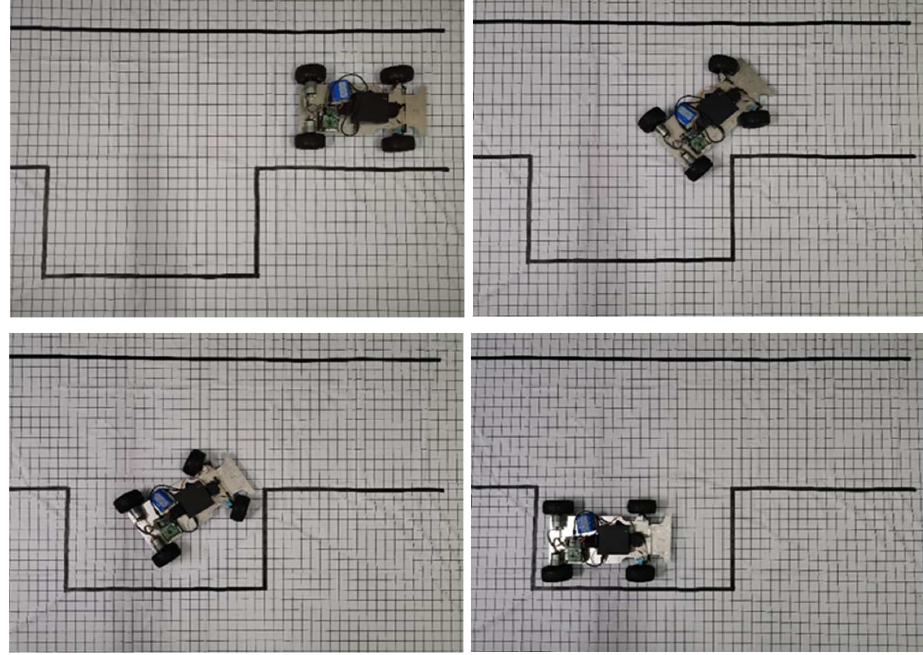
Figure 9. Parallel parking car experiment.